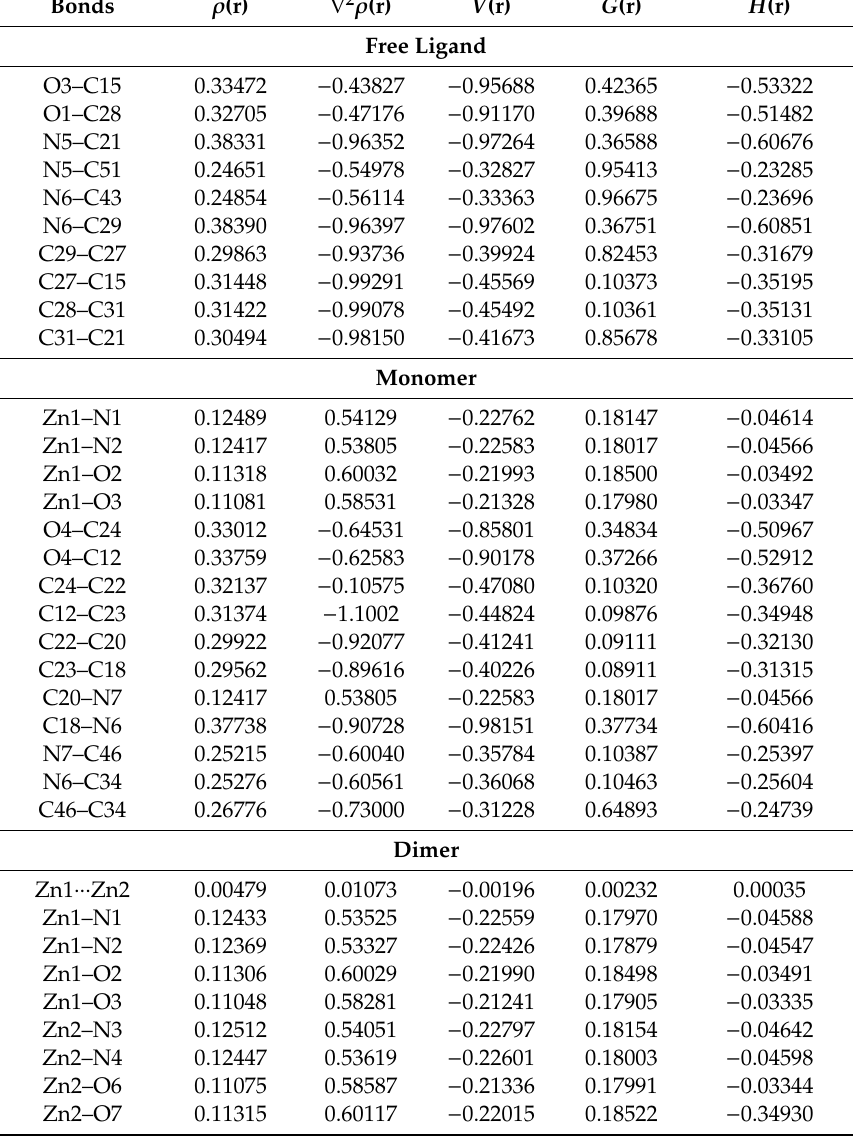
Table 4. Topological parameters of electron density: electron density ( ρ (r)), its Laplacian distribution ( ∇ 2 ρ (r)), potential energy density ( V (r)), kinetic energy density ( G (r)), and electronic energy density ( H (r)) at the bond critical points (3, − 1) corresponding to non-covalent interactions in [Zn(sal)](H 2 O). Parameters are all in the atomic unit